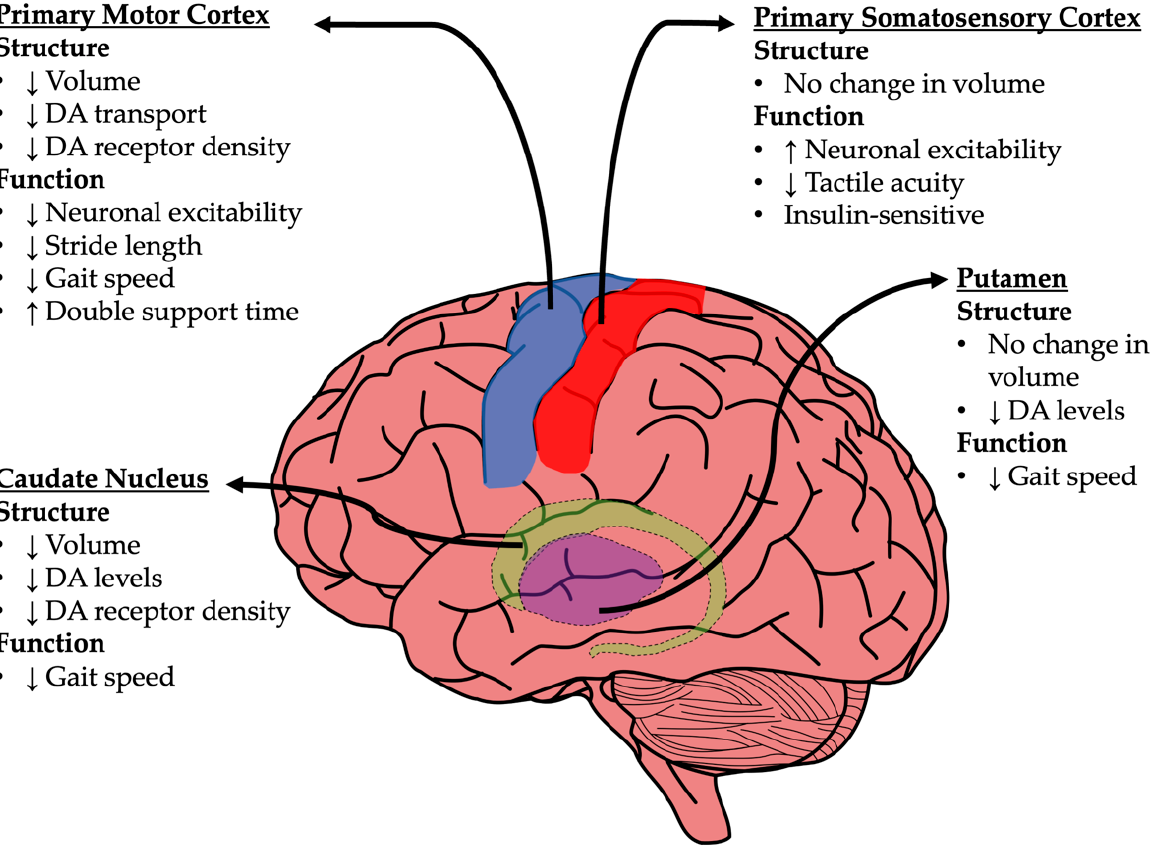
Figure 1. Aging-related structural and functional changes in key brain regions that control gait.